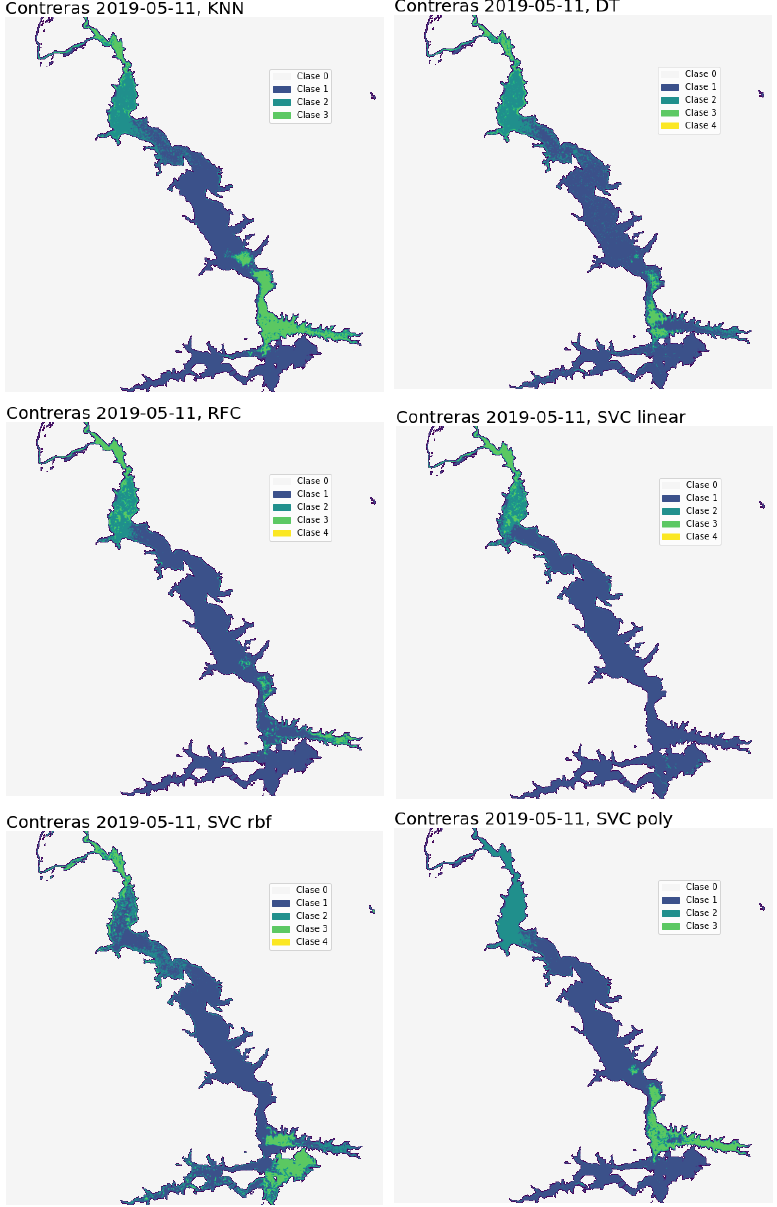
Figure 4. Comparison of the models in one image, 11 May 2019, Contreras reservoir: left top, KNN; right top, DTC; left center, RFC; right center, linSVC; left bottom, rbfSVC; right bottom, polySVC. Class 1: Clear, Class 2: Moderate, Class 3: Turbid, Class 4: Very Turbid. Class 0 is not really a class. It is assigned to the